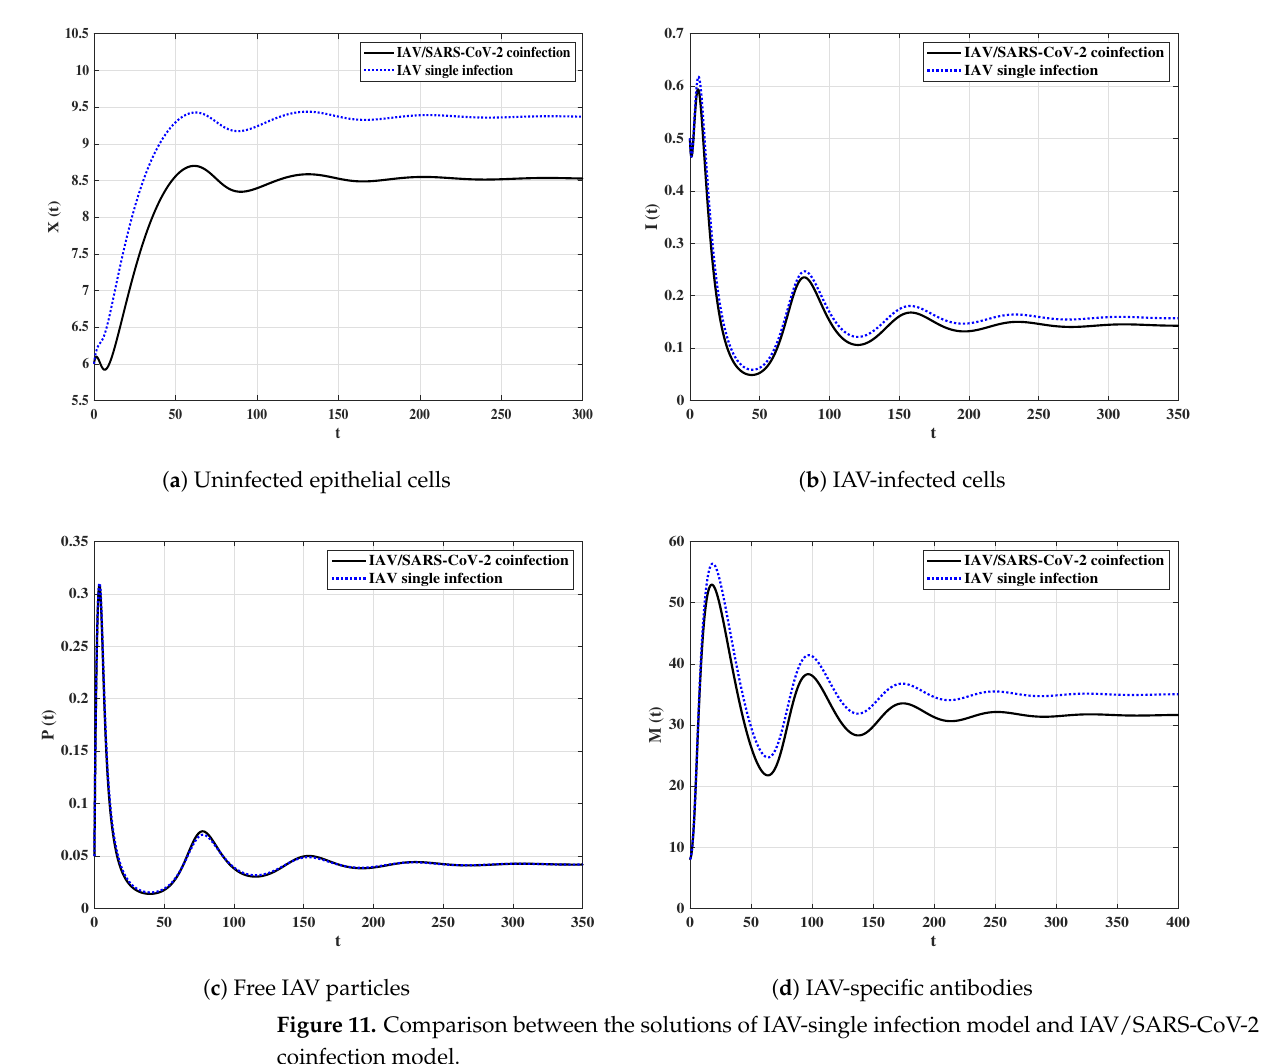
Figure 11. Comparison between the solutions of IAV-single infection model and IAV/SARS-CoV-2 coinfection